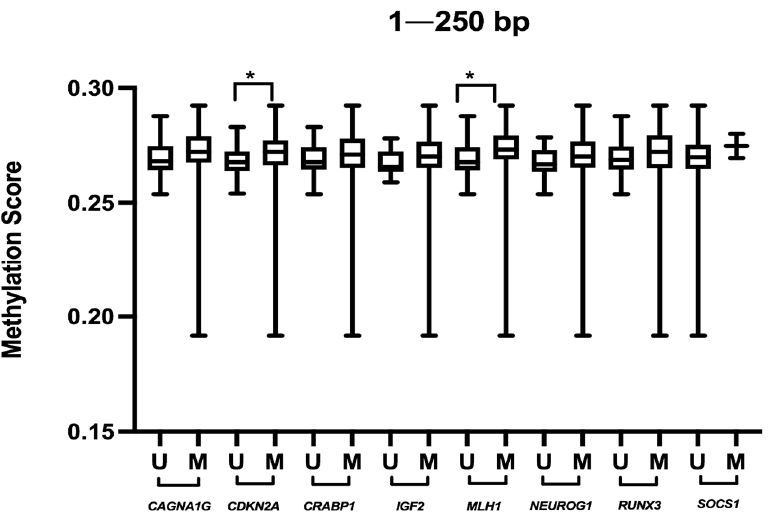
Figure 4. Global methylation score at 1–250 bp according to the methylation status of genes included in the CpG island methylation phenotype (CIMP) panel. U: unmethylated, M: methylated. * p < 0.05.